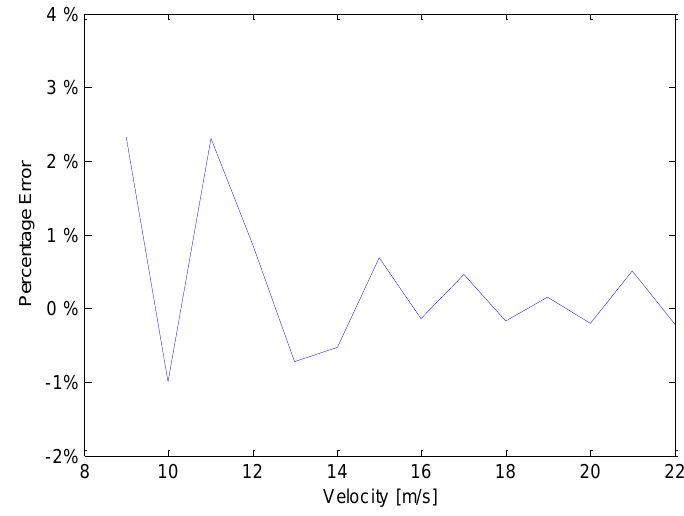
Figure 15. Percentage error analysis curve.